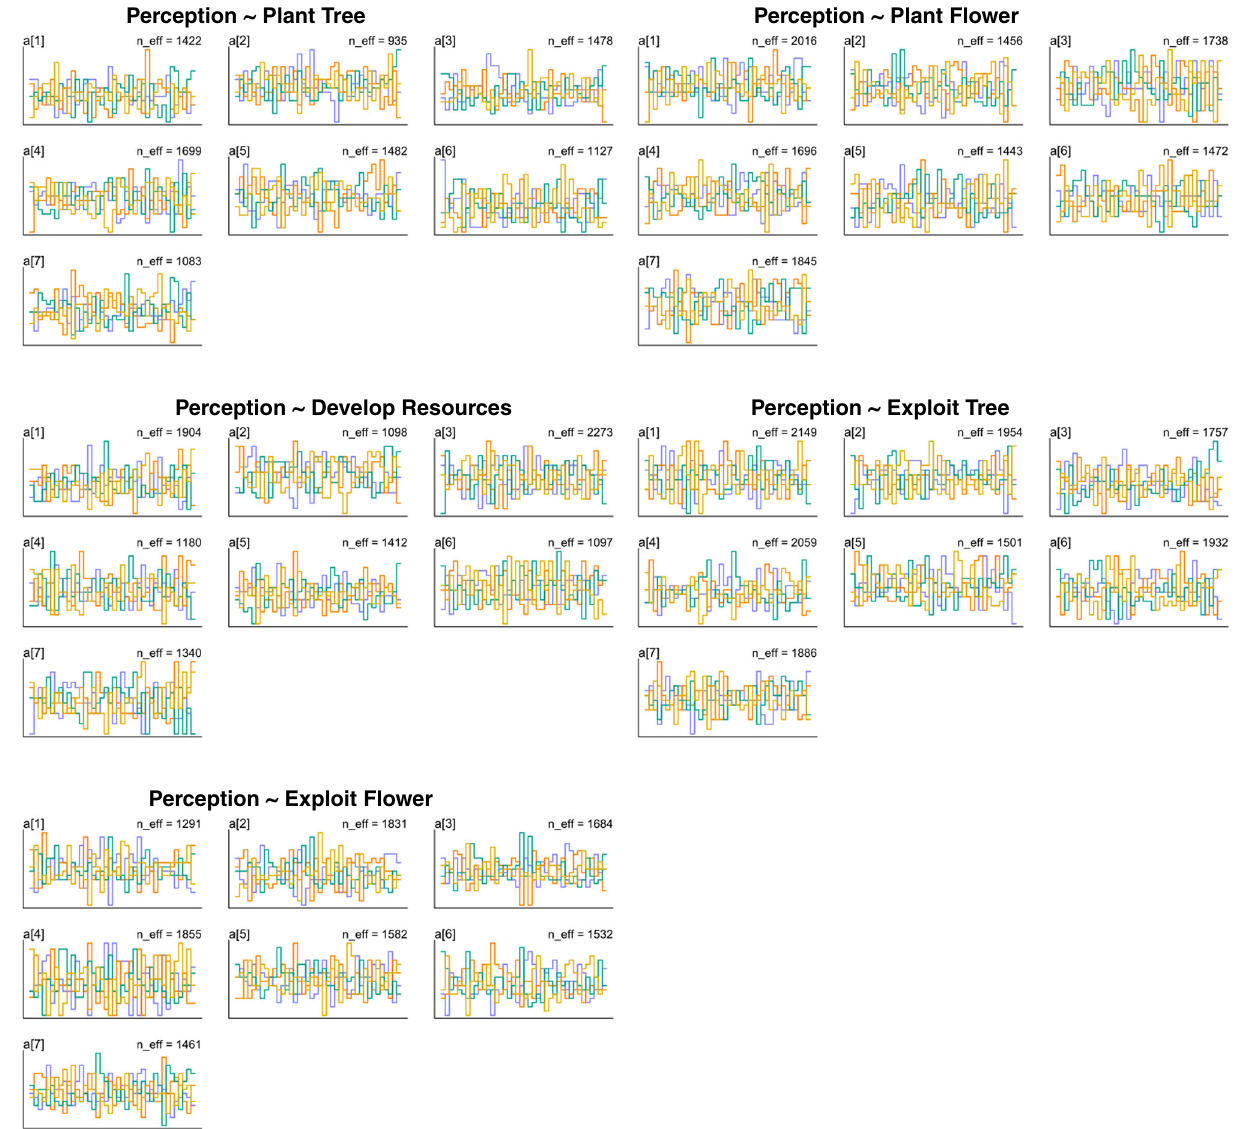
Fig. 2 The trace rank plots for the models. Note: Asian = 1, Black or African American = 2, Hispanic or Latino = 3, Caucasian = 4, Native American or American Indian = 5, Paci fi c Islander = 6, Other = 7.